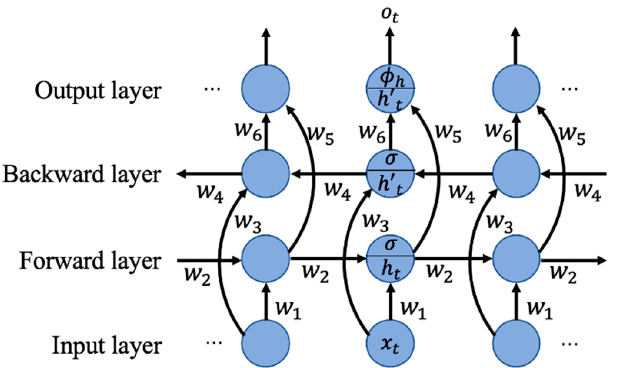
Figure 5. BiLSTM networks.